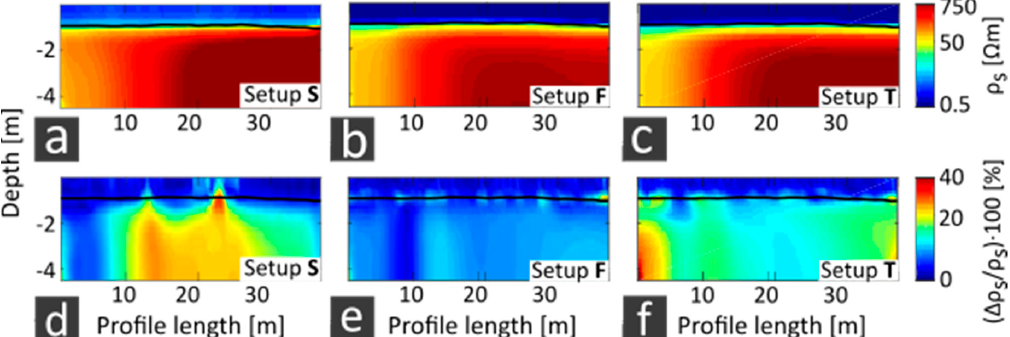
Figure 9. Comparative plotting of ( a – c ) arithmetical average values and ( d – f ) relative standard deviations of eight two-dimensional (2D) inversion results calculated from repetition profiles of Eckernförde Bay with the software RES2DInv. ( a , d ) Setup S (submerged), ( b , e ) setup F (floating) and ( c , f ) setup T (towed).